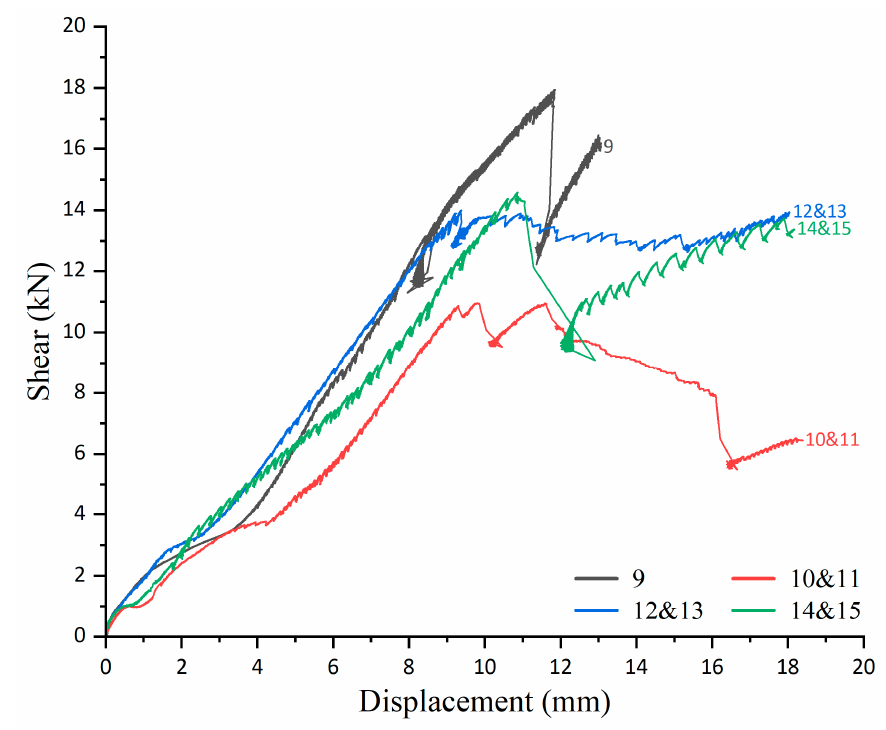
Figure 18. Shear performance of different preventing reinforcements. Applying the STS in the moment-constraining manner does not improve the joints’ shear performance. This is owing to the fact that the scheme does not correspond to the deformation caused by the in-plane shear force. Conversely, the fasteners inserted by means of the shear-constraining layouts, no matter whether with the bamboo nail or